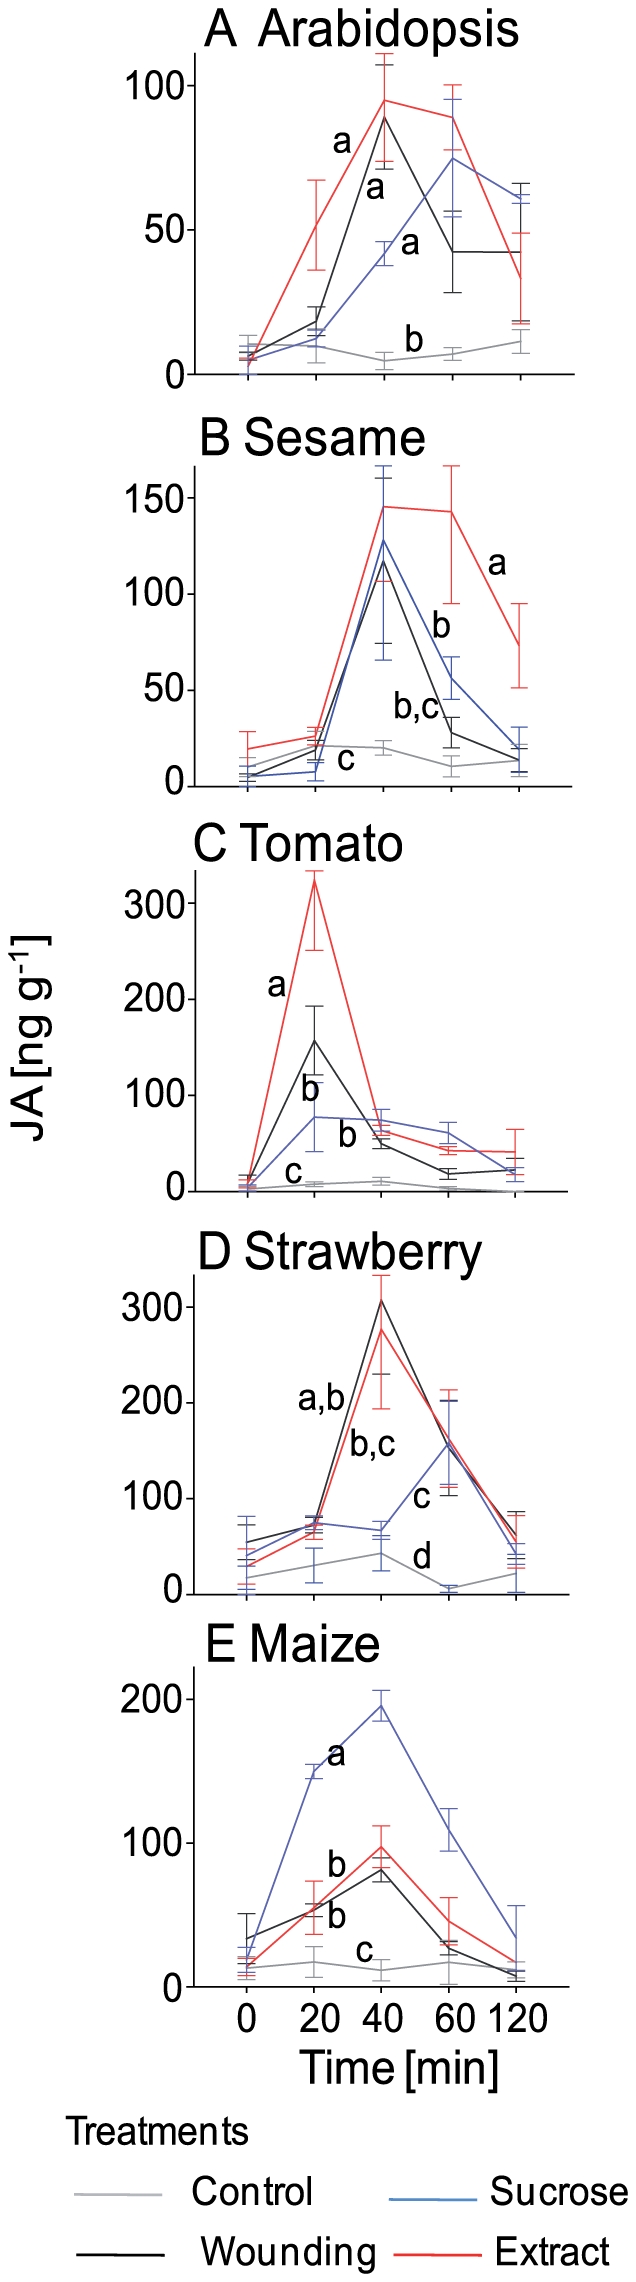
Endogenous levels of jasmonic acid (JA).Endogenous JA levels were quantified (ng per gram leaf fresh mass) at different times after the treatment in (A) Arabidopsis, (B) sesame, (C) tomato, (D) strawberry, and (E) maize. Lines marked with different letters indicate statistically significant differences among treatments (least significant difference post hoc tests, n = 5 biological replicates per mean).